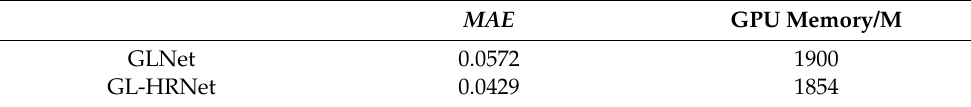
Table 5. Comparison of local branch